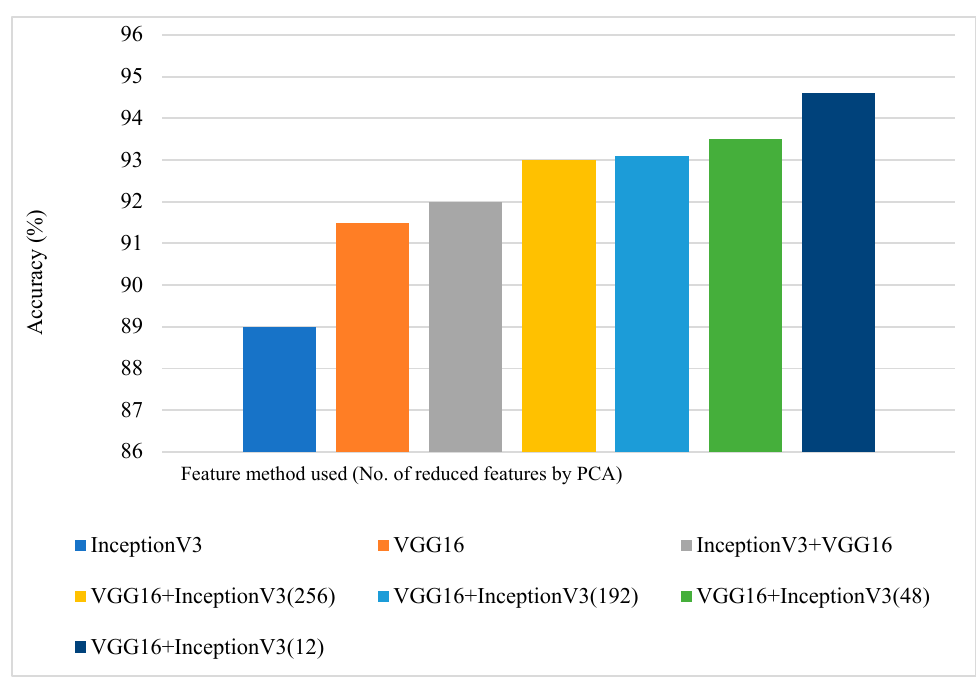
Figure 6. Accuracy results of the feature method used and the number of reduced features using PCA.